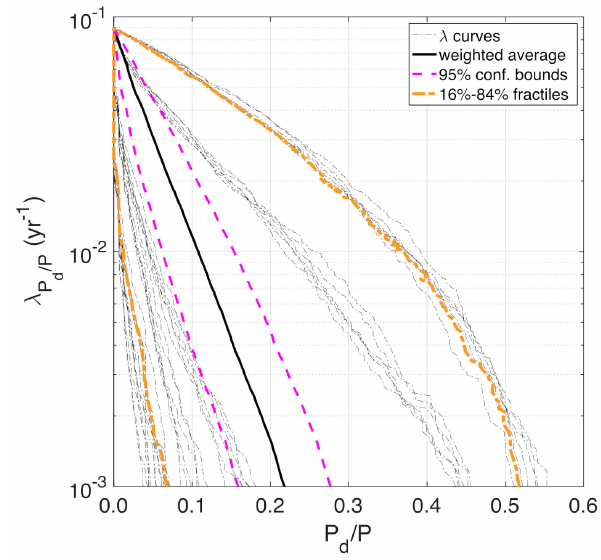
Figure 8. MAF curves of P d / P , with weighted average curve, 95% confidence bounds and 16% and 84% weighted fractile